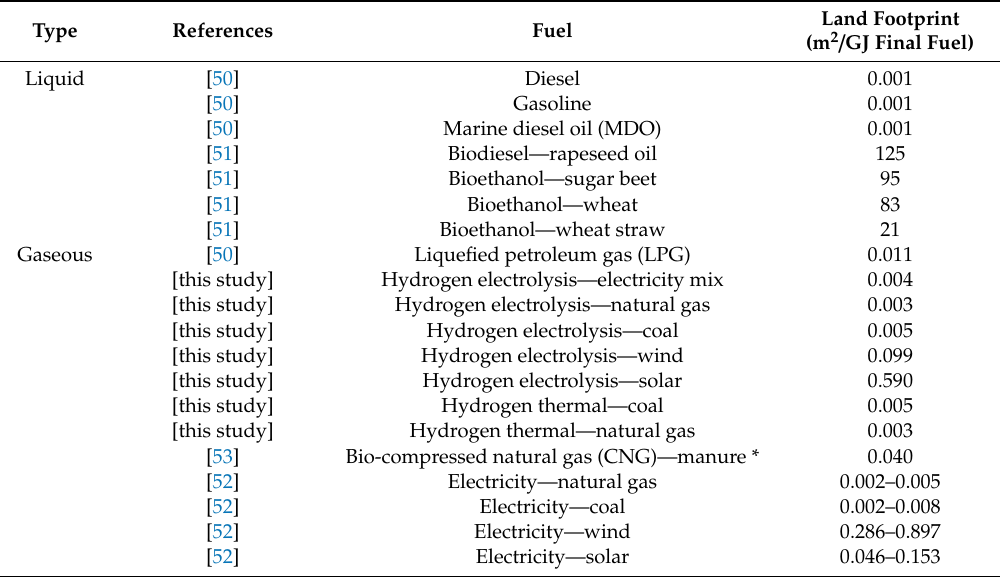
Table A2 gives the specific land footprints for transport fuels. Table A2. Specific land footprints for transport fuels. (Sources: United Nations Convention to Combat Desertification (UNCCD) [50] for typical values; Börjesson and Tufvesson [51] for crops and technologies in Northern Europe; this study; BioEnergyFarm [53]; Kaza and Curtis [52]).